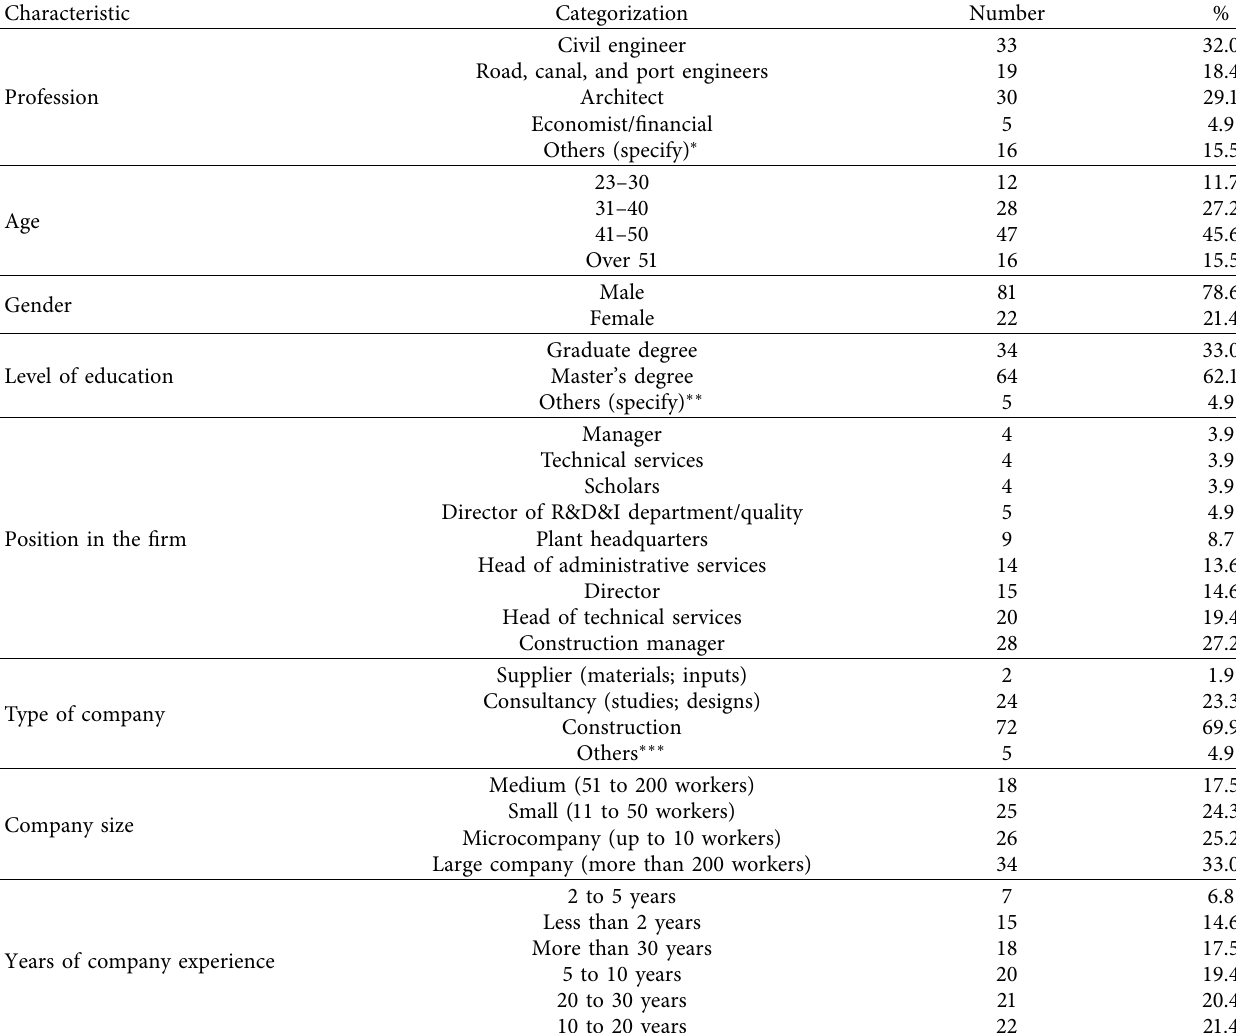
Table 2: Profiles of